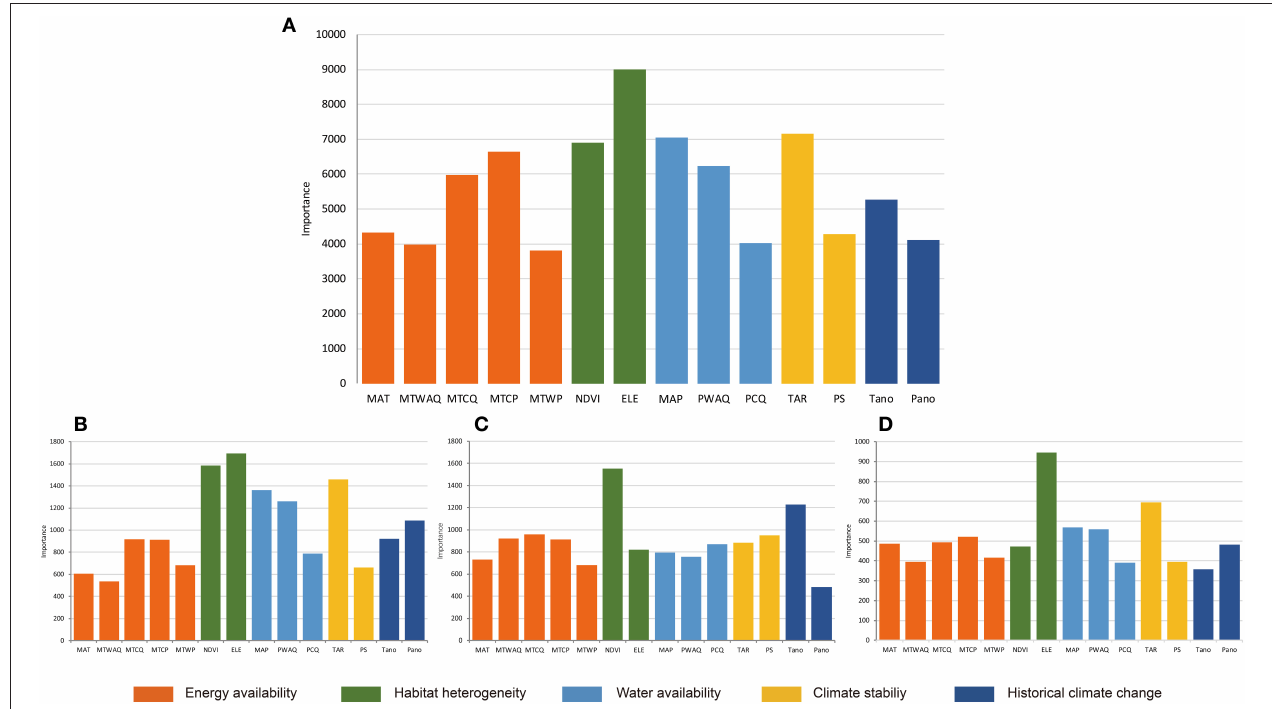
FIGURE 2 | Results of Random Forest for the importance of all variables for (A) Hemiptera; (B) Heteroptera; (C) Sternorrhyncha; (D) Auchenorrhyncha. Importance values (y-axis) are represented by the increase in node purity. MAT, mean annual temperature; MTWAQ, mean temperature of warmest quarter; MTCQ, mean temperature of coldest quarter; MTCP, min temperature of coldest month; MTWP, max temperature of warmest month; NDVI, normalized difference vegetation index; ELE, elevation range; MAP, mean annual precipitation; PWAQ, precipitation of warmest quarter; PCQ, precipitation of coldest quarter; TAR, temperature annual range; PS, precipitation seasonality; Tano, MAT anomaly; Pano, MAP